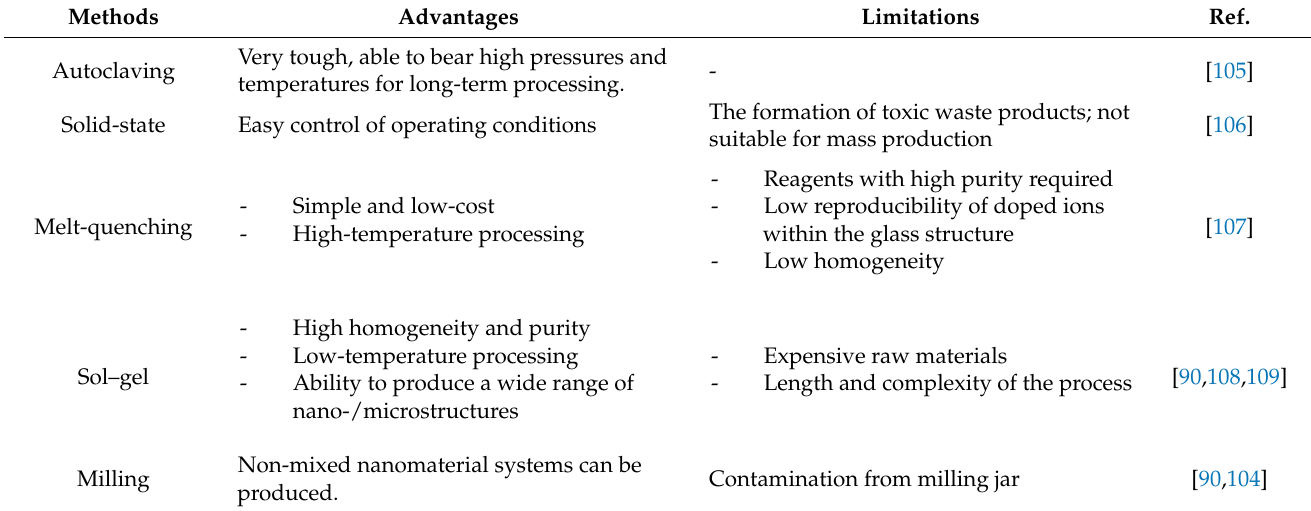
Table 6. Advantages and limitations of the methods in producing bioceramics and